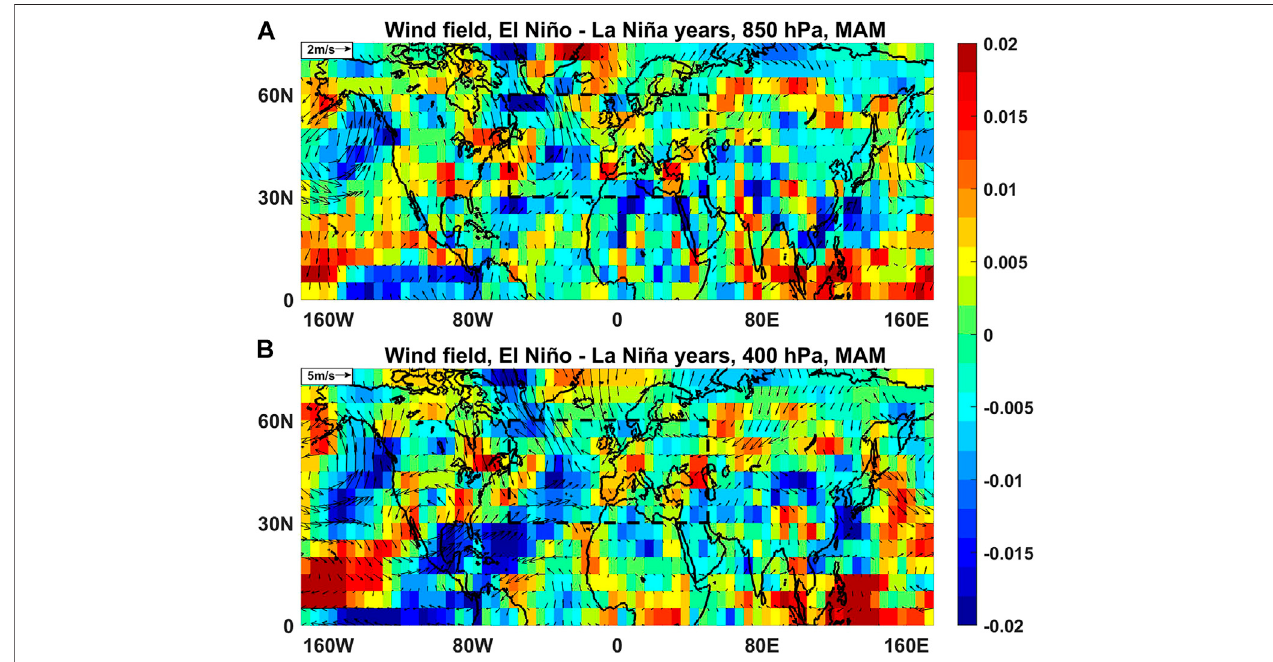
FIGURE 8 | (A) Difference in horizontal wind (arrows) between El Niño and La Niña years in MAM at 850 hPa. Overlaid is the corresponding difference in vertical velocity (in color, Pa s − 1 ). (B) The same as (A) , but at 400 hPa. Note the upward velocity is negative (in blue).